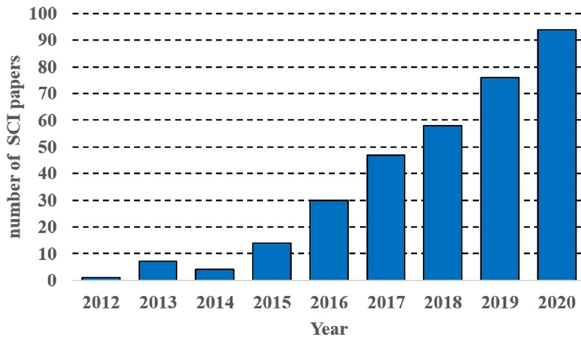
Figure 3: Annual number of SCI papers on GO - modi fi ed cement - based